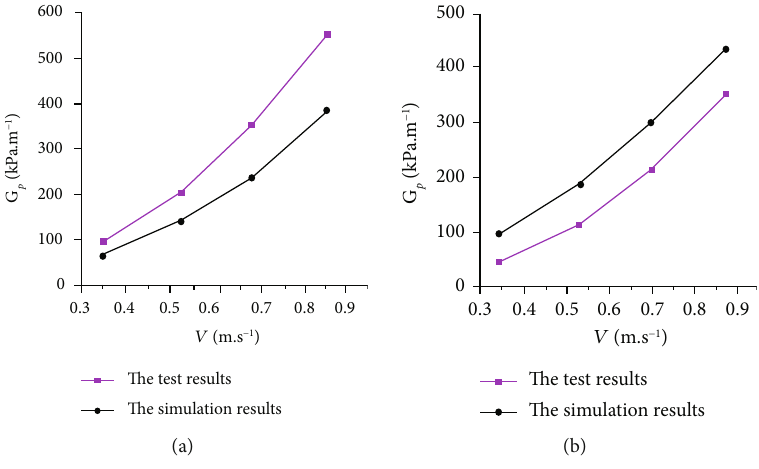
Figure 14: Distribution of the momentum source terms with 0 mm ≤ X (b) X 2 direction component.